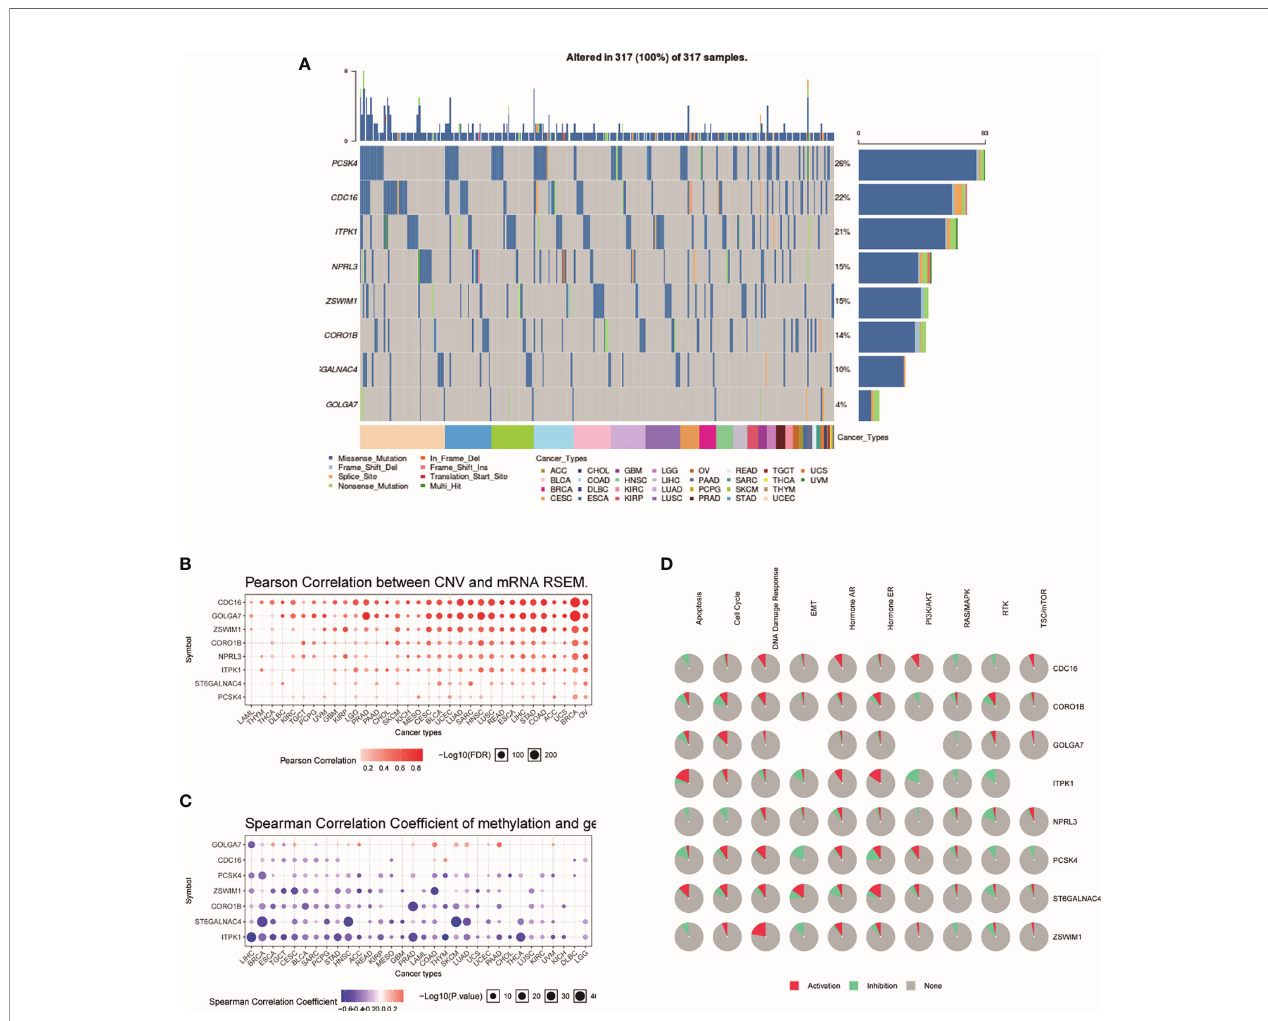
FIGURE 4 | Genome-wide analysis of TRRS. (A) An oncoplot, also known as a waterfall plot, shows the mutation distribution of the key genes in a gene set and a SNV classi fi cation of SNV types (including missense mutation, frame shift deletion, nonsense mutation, etc.). All selected cancers ’ samples are shown together. Side barplot and top barplots show the number of variants in each sample or gene. (B) This fi gure demonstrates the relation between CNV and gene expression. The red bubbles represent a positive correlation, which means that when gene has a high frequency of CNV, the gene expression will become upregulated. The deeper the color, the higher the correlation. The size of the point represents statistical signi fi cance; the greater the size, the more it is statistically signi fi cant. (C) The bubble plot shows the Spearman correlation coef fi cient of methylation and gene expression. Blue points represent a methylation downregulation in tumors and red points a methylation upregulation in tumors, in which the deeper the color, the greater the difference. The size of the point represents statistical signi fi cance; the greater the size, the more the signi fi cance. (D) This plot displays the global activity of genes in selected cancer